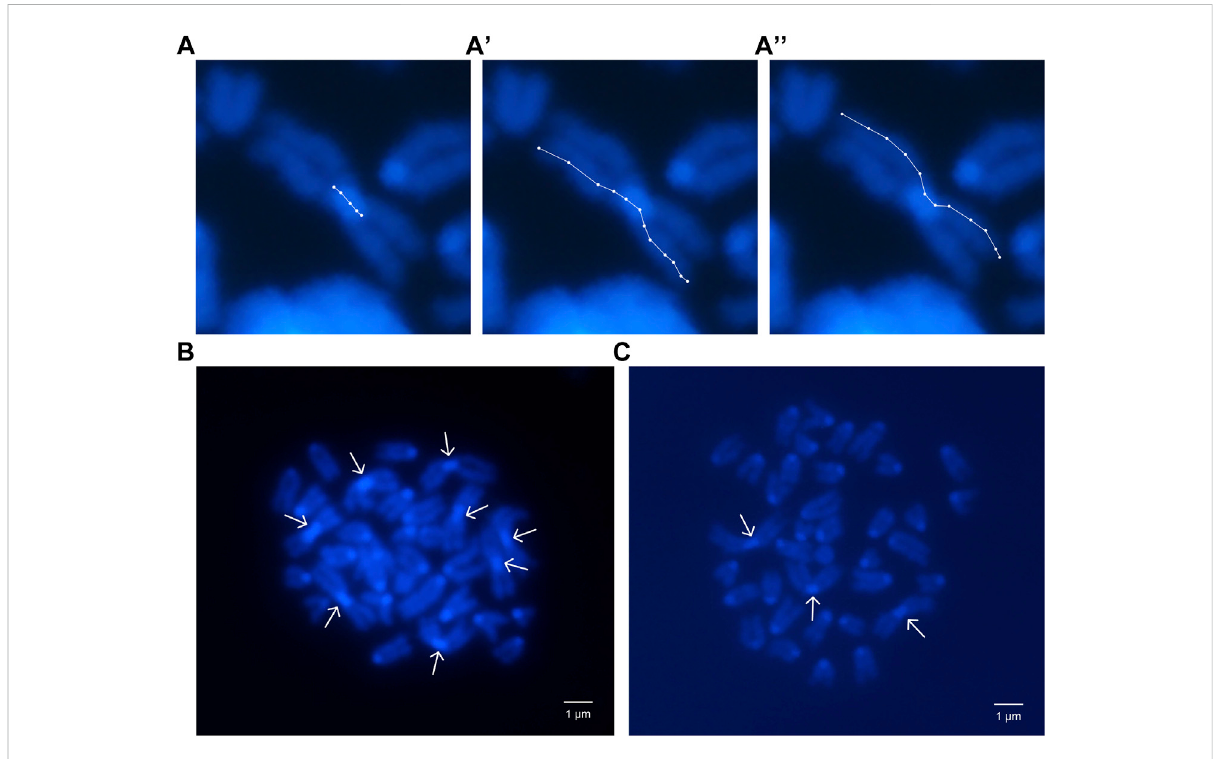
FIGURE 3 Mitotic chromosomes stained with DAPI. (A) Pericentromeric region length of a Rb chromosome; (A 9 ,A 99 ) Sister chromatid lengths of same chromosome. (B) Heterozygous parent 2n = 32 metaphase plate. Arrows show 8 metacentric Rb chromosomes. (C) Descendent C, 2n = 37 metaphase plate. Arrows show 3 metacentric Rb